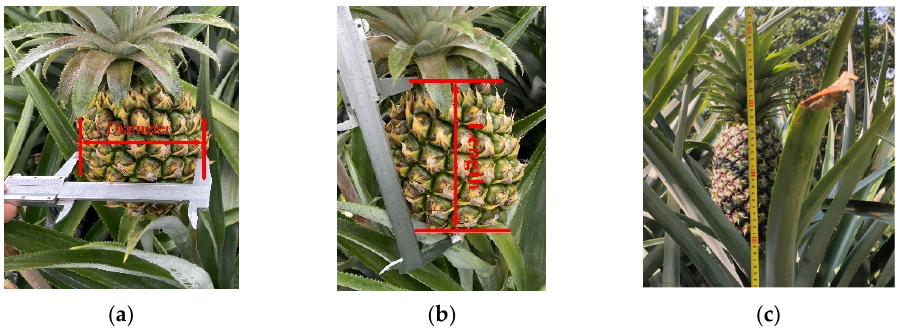
Figure 1. Measurement of pineapple physical property parameters. ( a ) Diameter of pineapple. ( b ) Length of pineapple. ( c ) Height of plant.